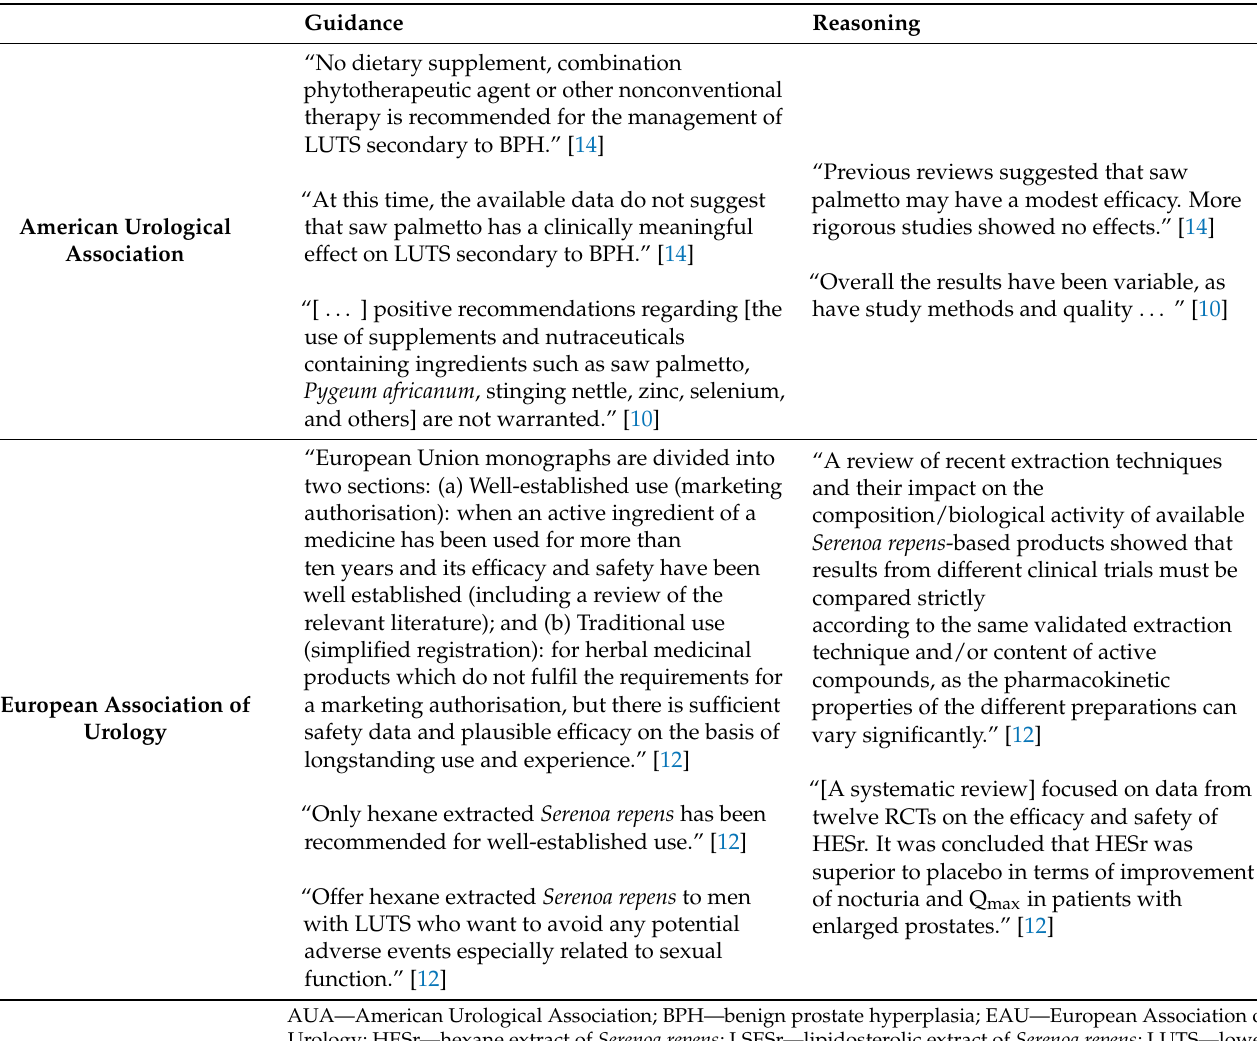
Table 1. Comparison of AUA and EAU guidelines with regard to